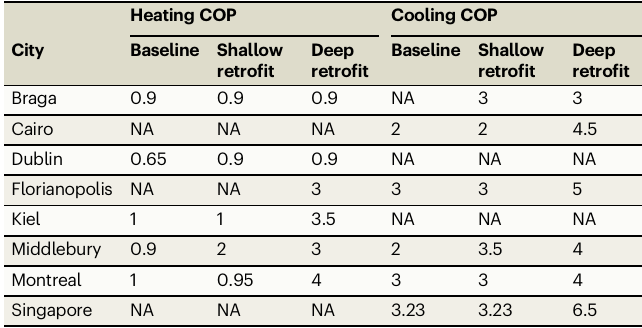
Table 5 | Average heating and cooling COPs for the baseline, shallow, and deep retro fi t templates Heating